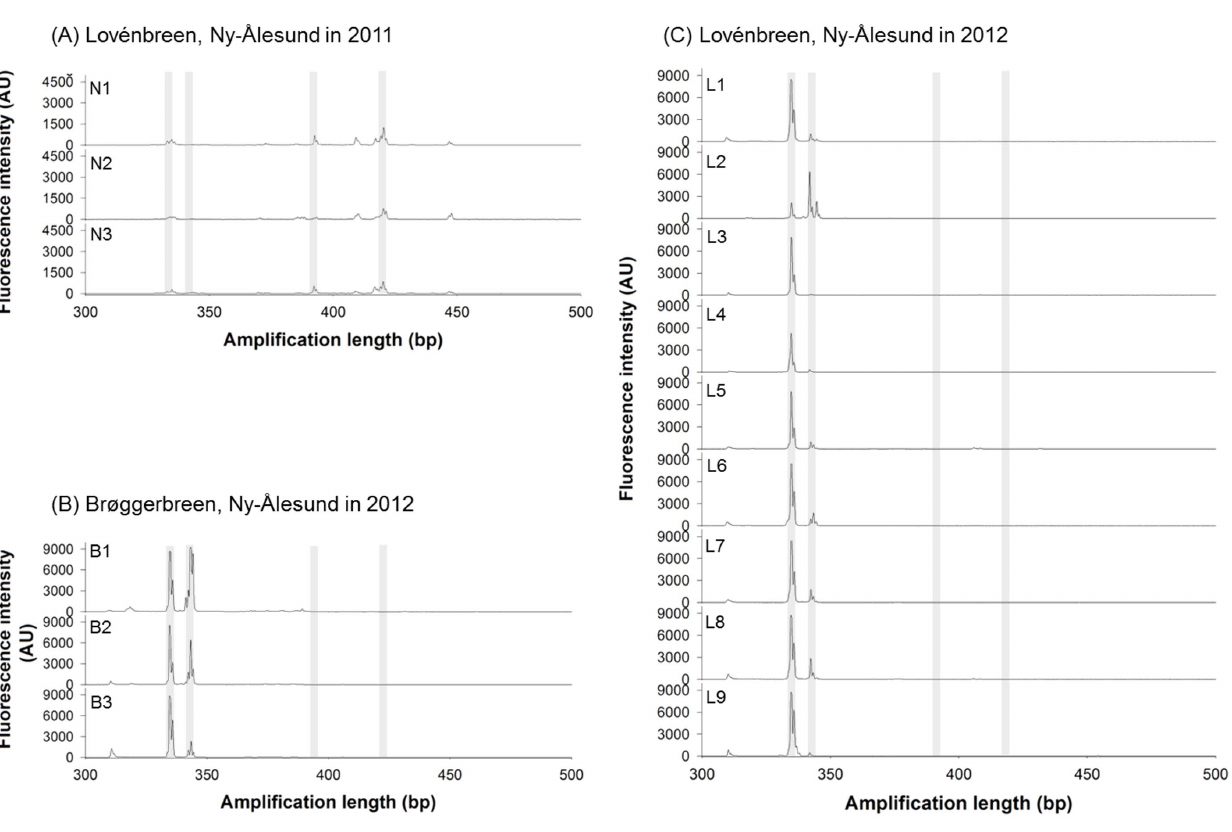
Figure 2. LH profiles of 15 fecal samples collected from different regions in between 2011 and 2012. (a) Love´nbreen, Ny-A˚lesund in 2011; (b) Brøggerbreen, Ny-A˚lesund in 2012; (c) Love´nbreen, N-A˚lesund in 2012. Shaded bars on profiles represented major peaks, which were the most contributing variables on first two principal components in PCA analysis.